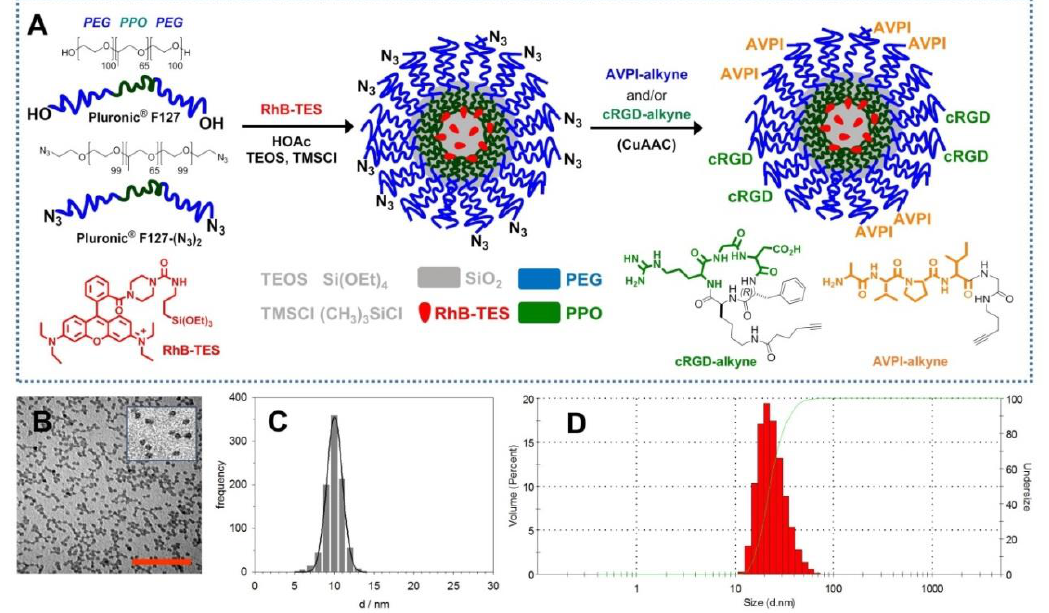
Figure 1. ( A ) Molecular components involved in the synthesis of nanoparticles (NPs)–N 3